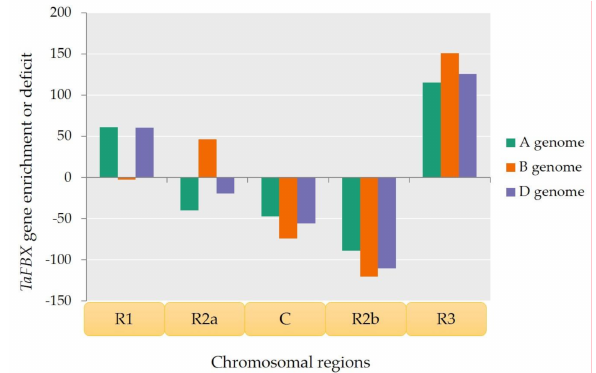
Figure 3. TaFBX gene enrichment or deficit among the five chromosomal regions of the three bread wheat subgenomes. The excess or deficit was calculated for each chromosomal region by the subtraction of the observed TaFBX number from the theoretical